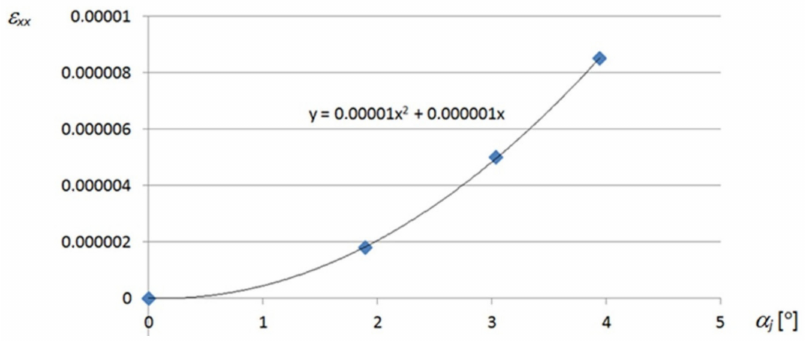
Figure A2. A non-linear relation between the strains ε xx corresponding to the normal stresses σ xx acting the along longitudinal axes and α j unit angle at the crosswise ends of an effectively twisted fold.